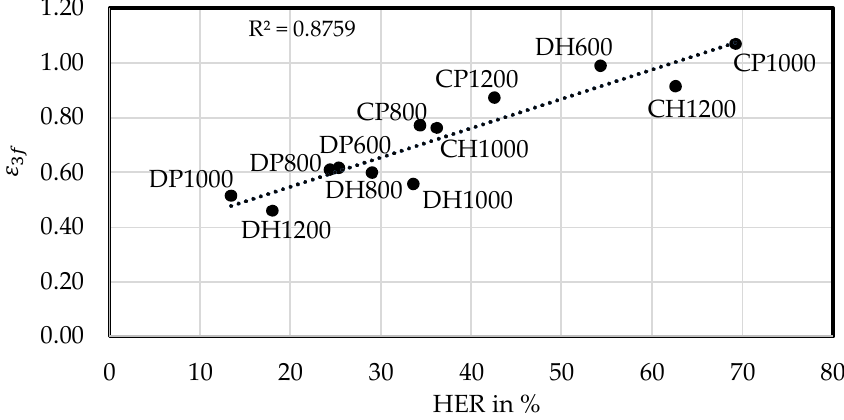
Figure A6. Global formability: Correlation between true uniform strain and n-value.